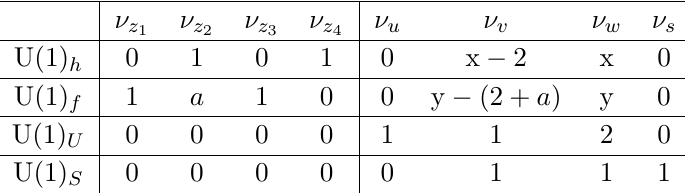
Table 2 . GLSM charges of the toric coordinates of the Bl 1 P 2